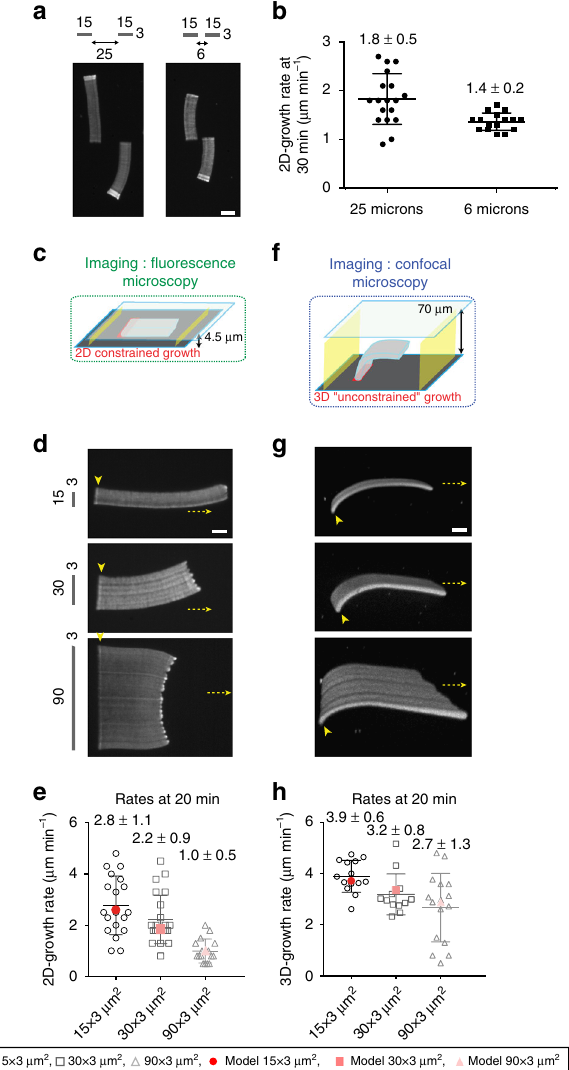
Fig. 2 Actin assembly induces a local monomer depletion that controls the growth rate of branched actin networks. a LMs were constrained as in c and grown from 3×15 µ m 2 NPF-coated bars either spaced by 25 or 6 µ m. b The growth rate was measured at 30min. Error bars show mean s.d. for n LMs per condition, n = 18 from four experiments (25 µ m), n = 16 from six experiments (6 µ m). c – f Actin assembly was followed for LMs growing from NPF-coated nucleation bars of 3 µ m width and increasing length, as mentioned. The growth was followed for 2D-like con fi guration in small volume with 4.5 µ m space between glass and coverslip c , d , e , or for 3D-like con fi guration in a larger reconstituted volume with 70 µ m space between glass and coverslip f , g , h . e , h 2D- and 3D-growth rates measured in each case ( open black symbols ). Mathematical modeling ( red symbols in e , h ) of the experimental growth rates measured in d , g . Error bars show mean s.d. for n LMs, n = 19 from four experiments (15 µ m), n = 23 from seven experiments (30 µ m), and n = 16 from four different experiments (90 µ m) in e and n = 14 from six experiments (15 µ m), n = 12 from six experiments (30 µ m), and n = 16 from six experiments (90 µ m) in h . a , d , g LM growth was reconstituted with the standard puri fi ed medium containing actin-pro fi lin complex, Arp2/3 complex and capping protein, as described in the Methods section. All speci fi ed lengths are in µ m (see also related Supplementary Figs 3, 4, 5 and 6). Scale bars in are 15 µ